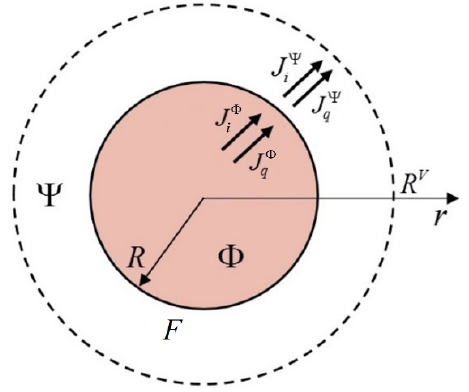
Figure 1. Diagram of the growth of a new phase particle from melt.